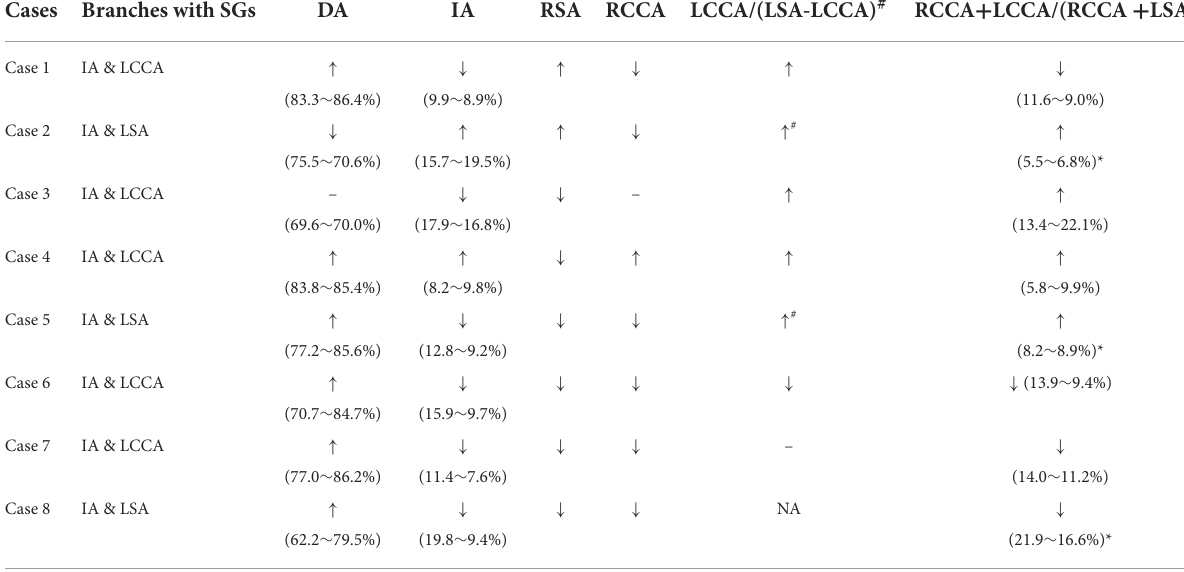
TABLE 2 Perfusion ratio changes of descending aorta and